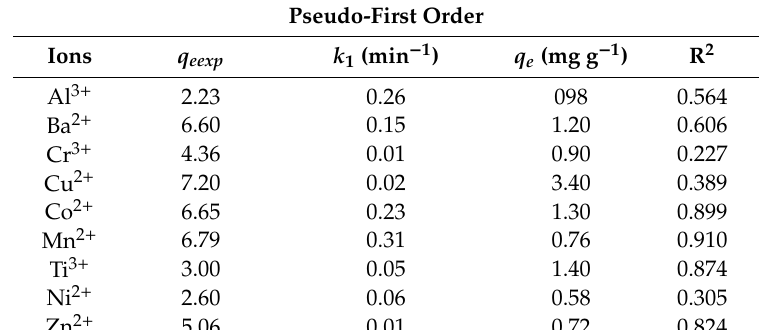
Table 4. Kinetic parameters for pseudo-first order and second order model.